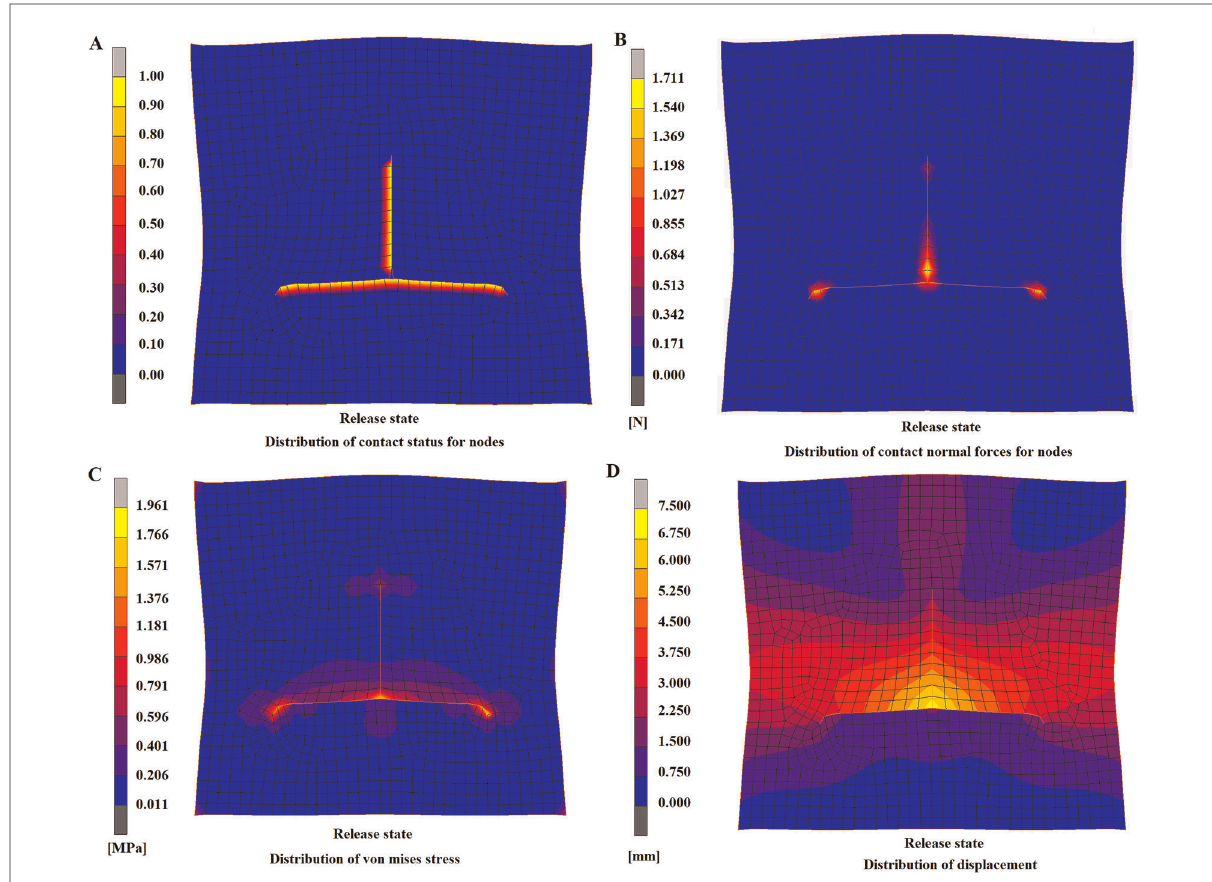
FIGURE 7 A-T fl ap at release state. ( A ) Distribution of contact state for nodes. ( B ) Distribution of contact forces for nodes. ( C ) Distribution of von mises stress. ( D ) Distribution of